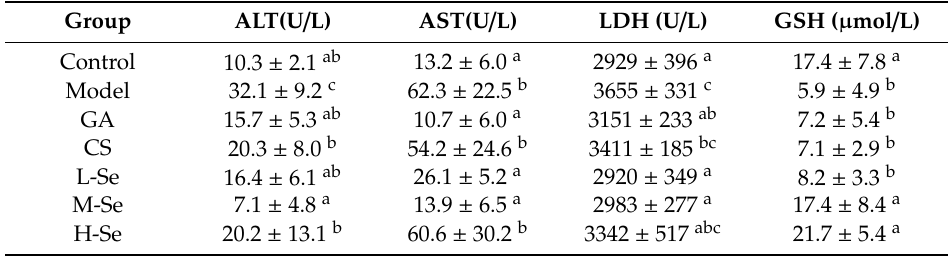
Table 4. Serum alanine transaminase (ALT), aspartate transaminase (AST), lactic dehydrogenase (LDH), and glutathione (GSH) levels in KM mice ( n =